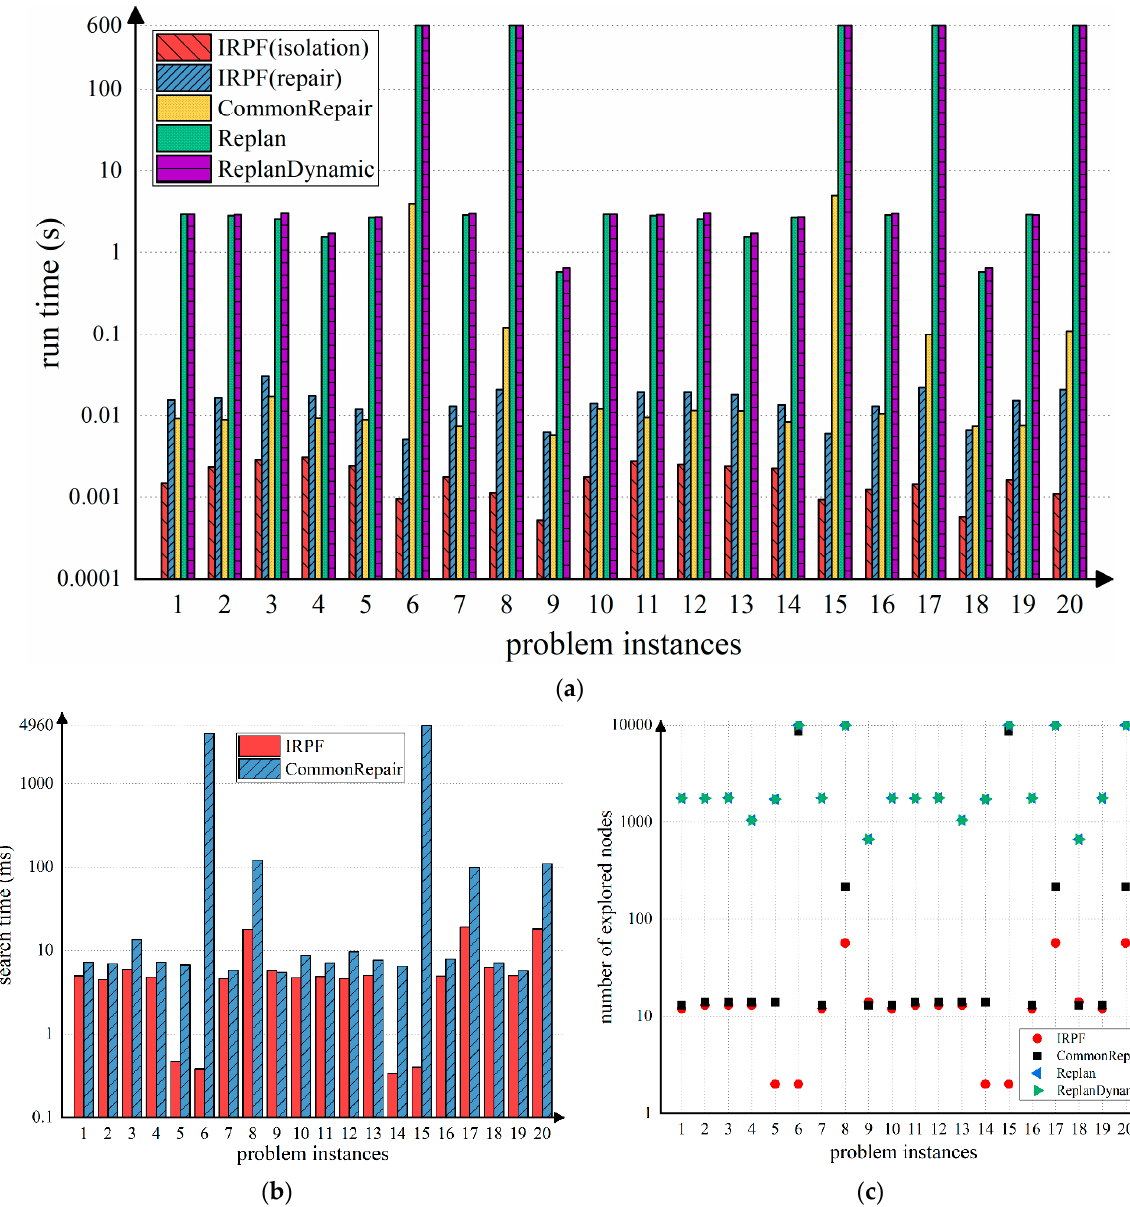
Figure 4. Comparison of test results of different methods in the satellite system, including ( a ) run time, ( b ) search time, ( c ) number of explored nodes. time, ( b ) search time, ( c ) number of explored